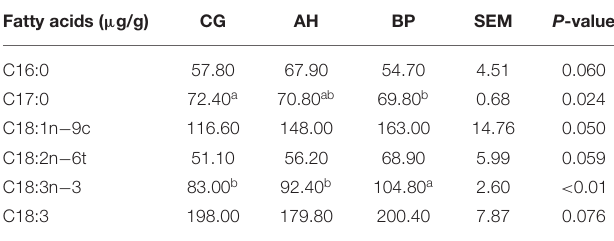
Mean values without common superscript (a and b) differ significantly among CG, AH, and BP groups (p < 0.05).